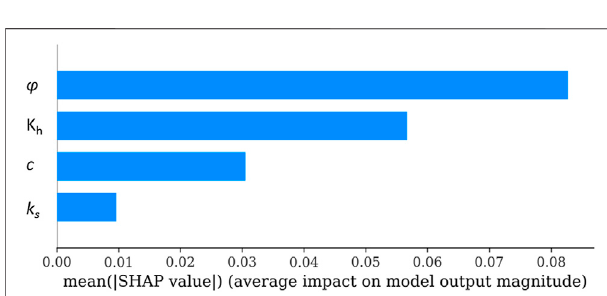
FIGURE 7 | Relative importance of features calculated from the CatBoost